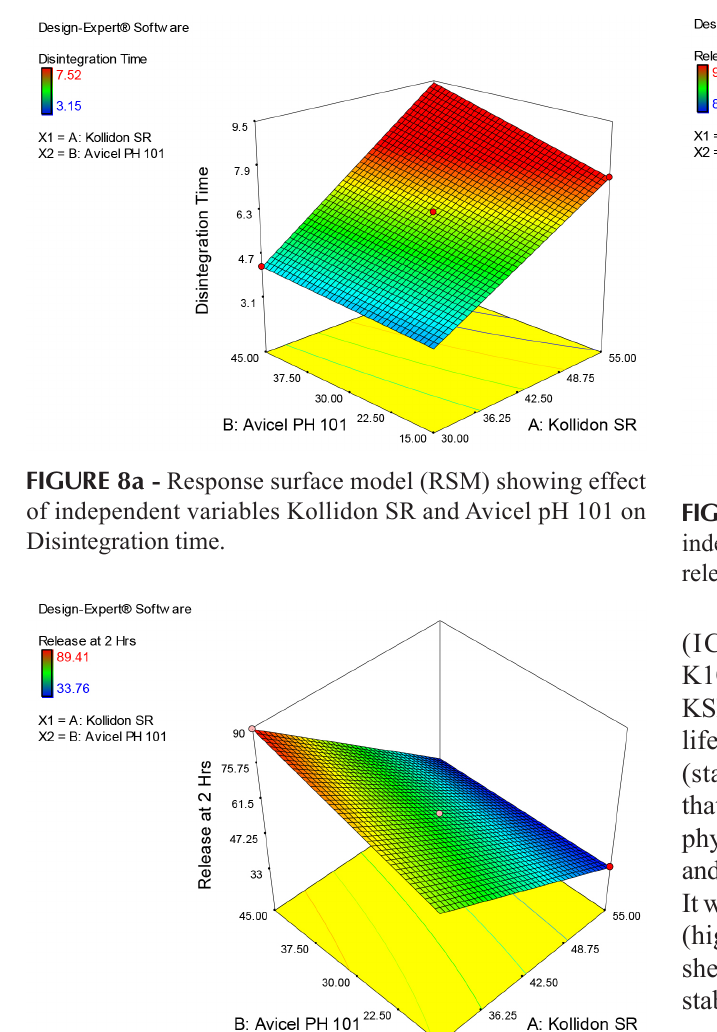
FIGURE 8b - Response surface model (RSM) showing effect of independent variables Kollidon SR and Avicel pH 101 on Drug release in 2 hours.